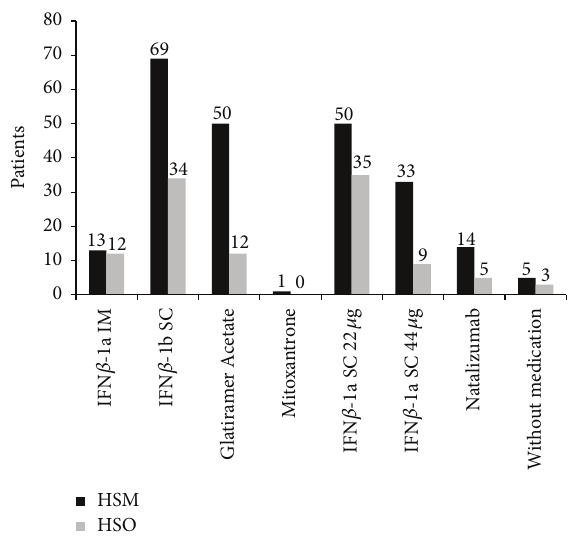
Figure 1: Most patients are treated with first-line drugs.